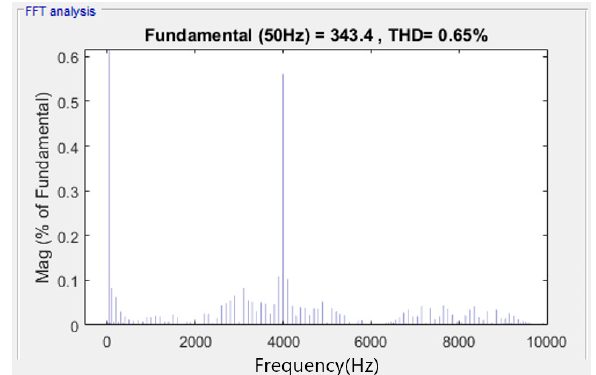
Figure 4. THD for LS PWM 𝑎 (cid:2869) = 0.2, 𝑎 (cid:2870) = 0.45, 𝑎 (cid:2871) = 0.7 , and 𝑚 = 0.9 .